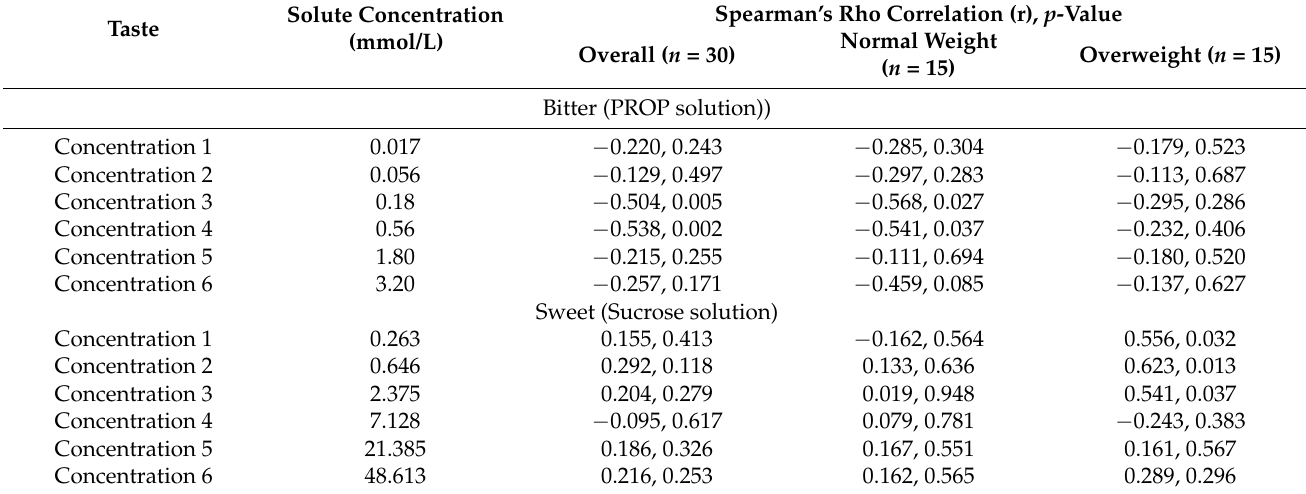
Figure 4. Intensity rating and taste preference for ‘sweet’ between the study groups. The Spearman correlation test was used, p -value < 0.05.